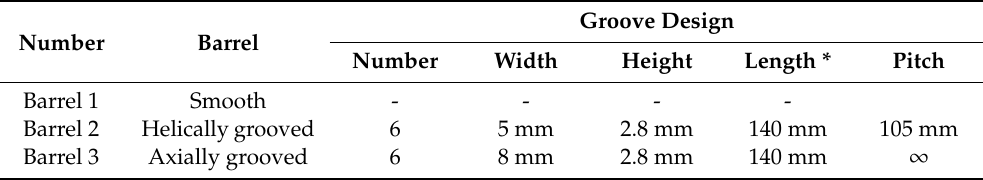
Table 3. Comparison of barrel designs.